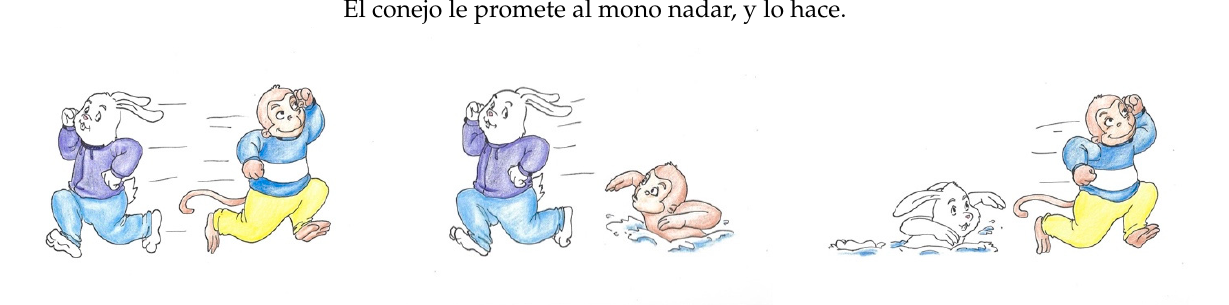
Figure A34. Filler stimulus 9.